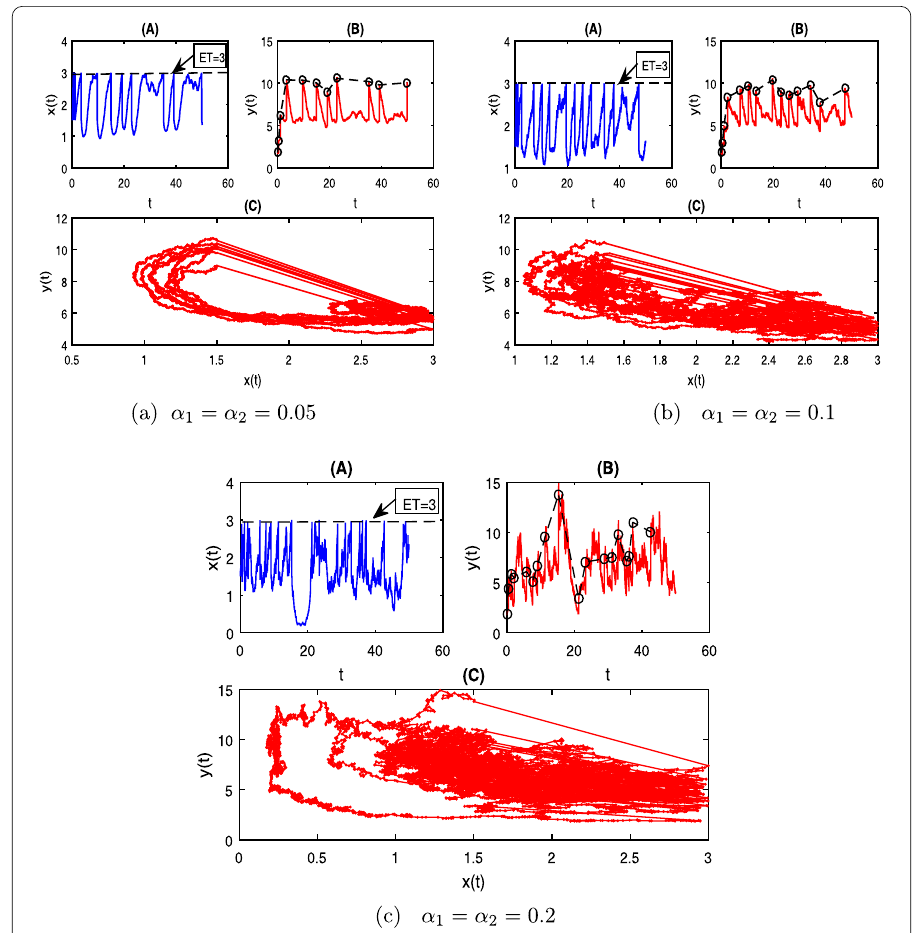
Figure 3 The change trend of solutions of model (4.1): The parameter values are fixed as follows: initial value ( x 0 , y 0 ) = (3,1), r = 3, K = 12, β = 0.3, λ = 0.5, η = 0.4, ET =